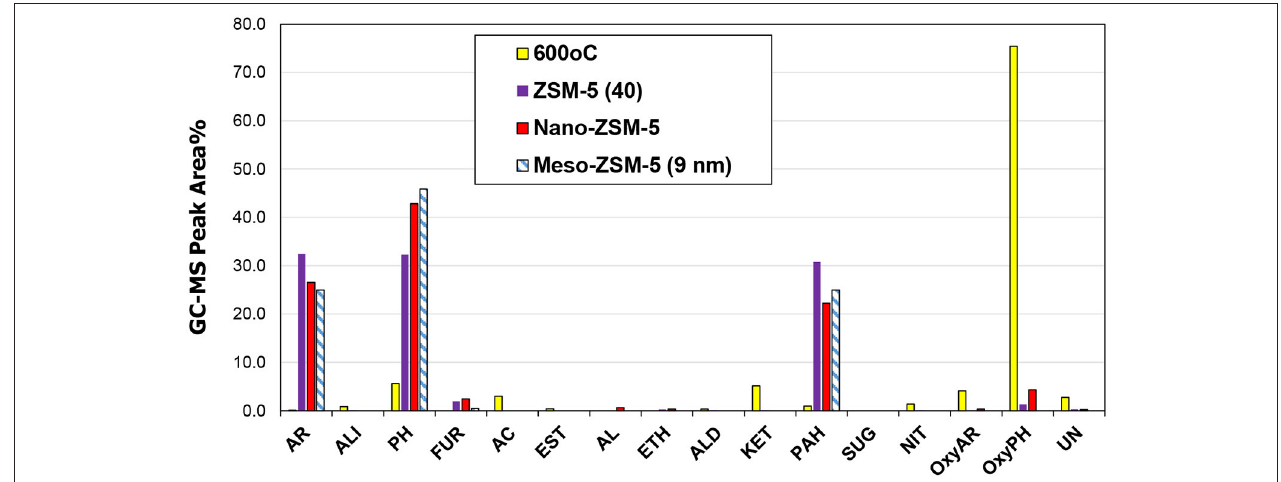
FIGURE 12 | Relative concentration of the various groups of compounds in the bio-oils derived by non catalytic and catalytic fast pyrolysis (CFP) of kraft lignin with conventional microporous, nano-sized and mesoporous ZSM-5 zeolites (fixed bed unit, 600 ◦ C, C/L = 1).